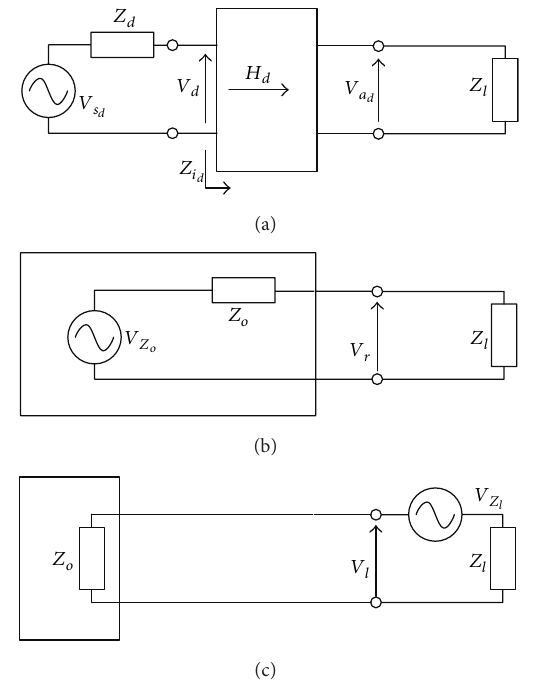
Figure 3: Equivalent models for the active, resistive, and receiver noise